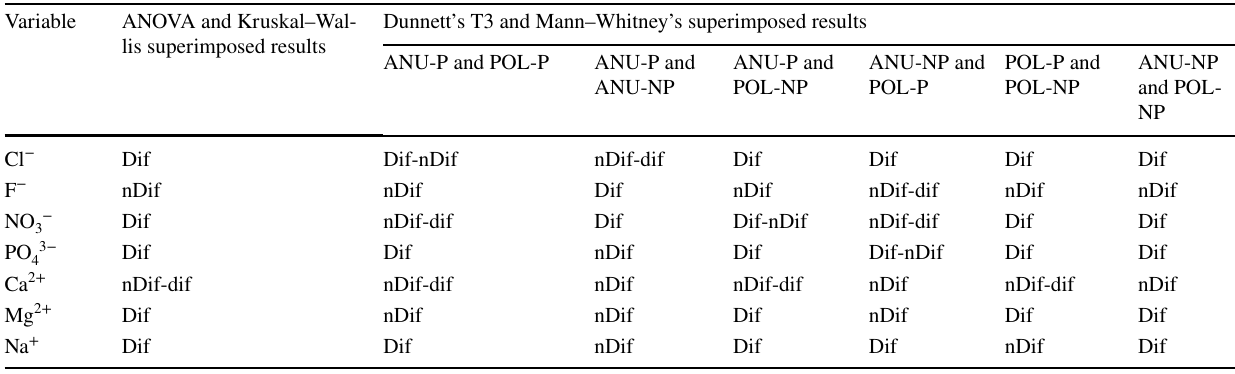
Table 6 Superimposed results from ANOVA with Dunnett’s T3 post hoc test and Kruskal–Wallis (KW) with Mann–Whitney’s post hoc tests for primary data